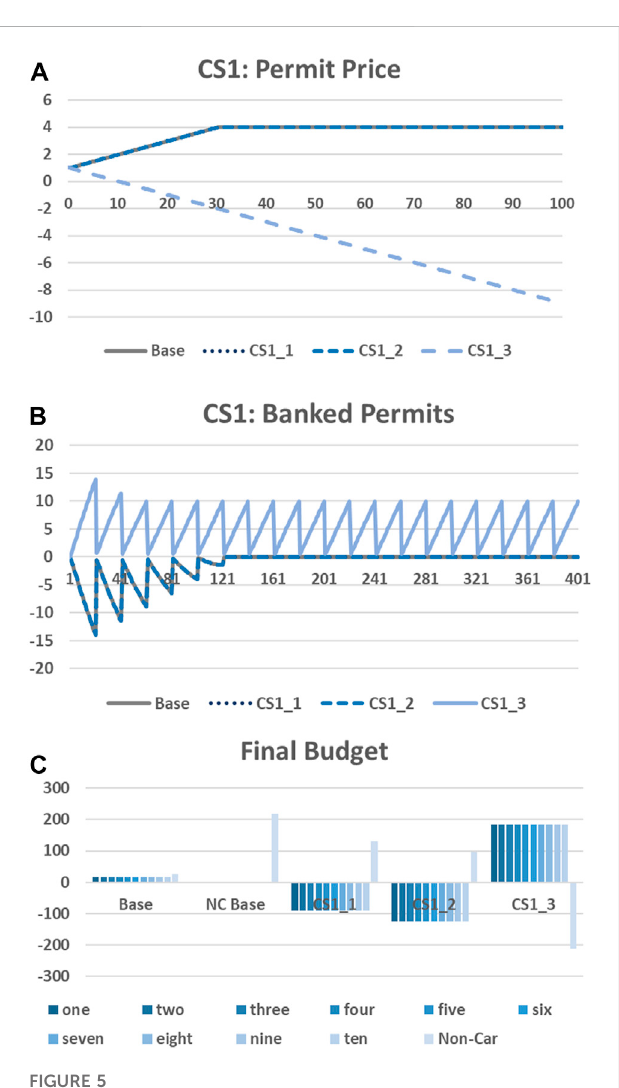
FIGURE 5 CS1 (A) Permit price; (B) Banked permits; (C) Final